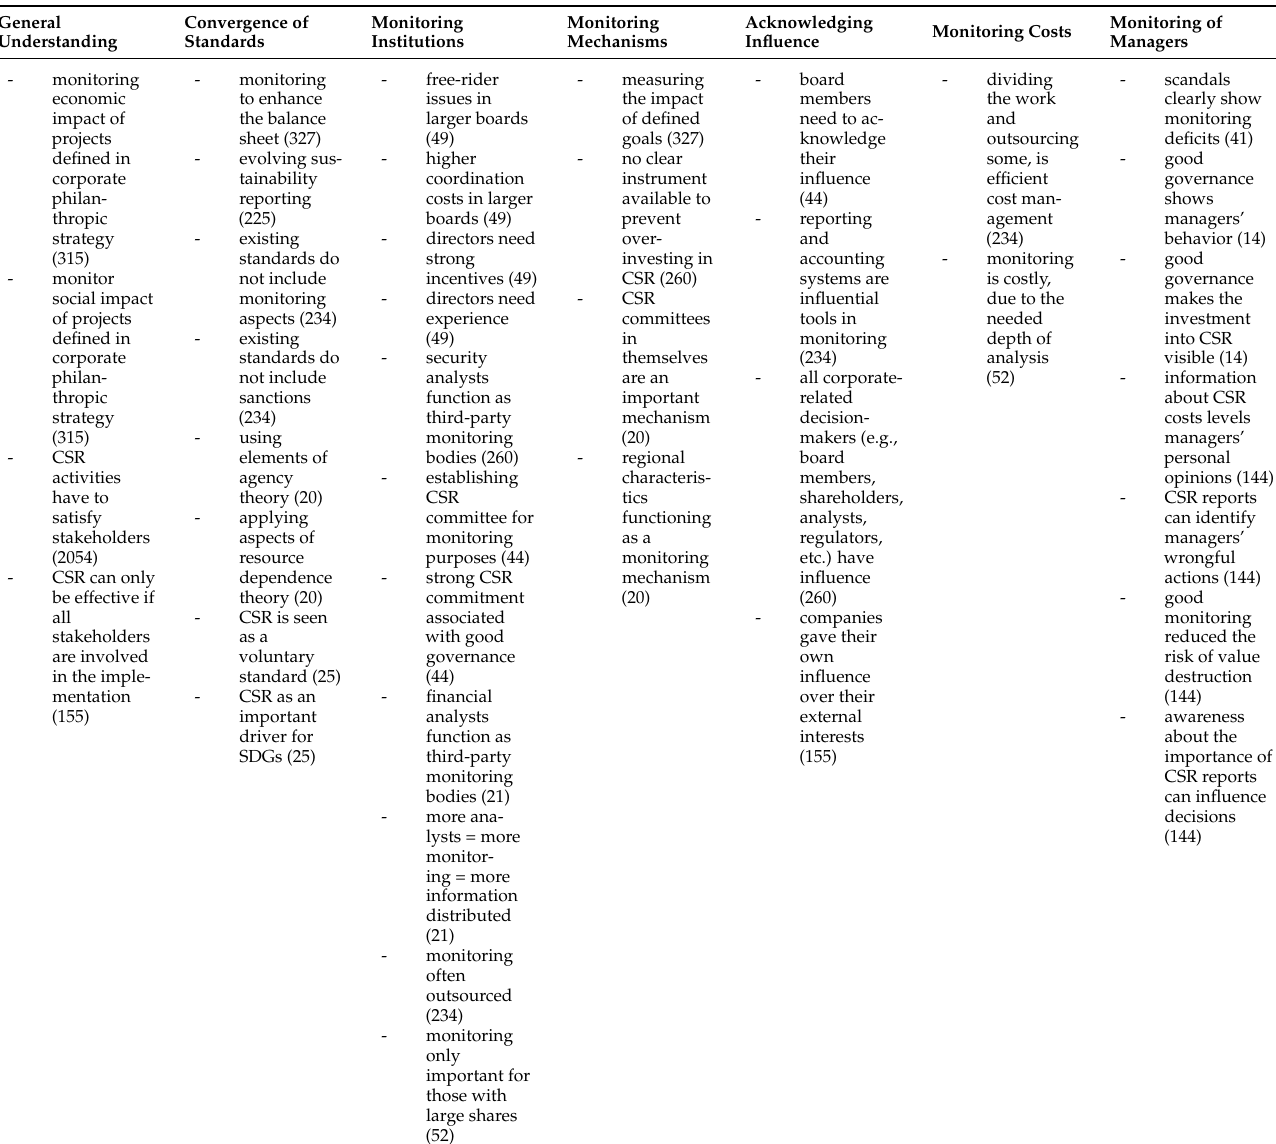
Table 1. Overview of monitoring insights from the systematic